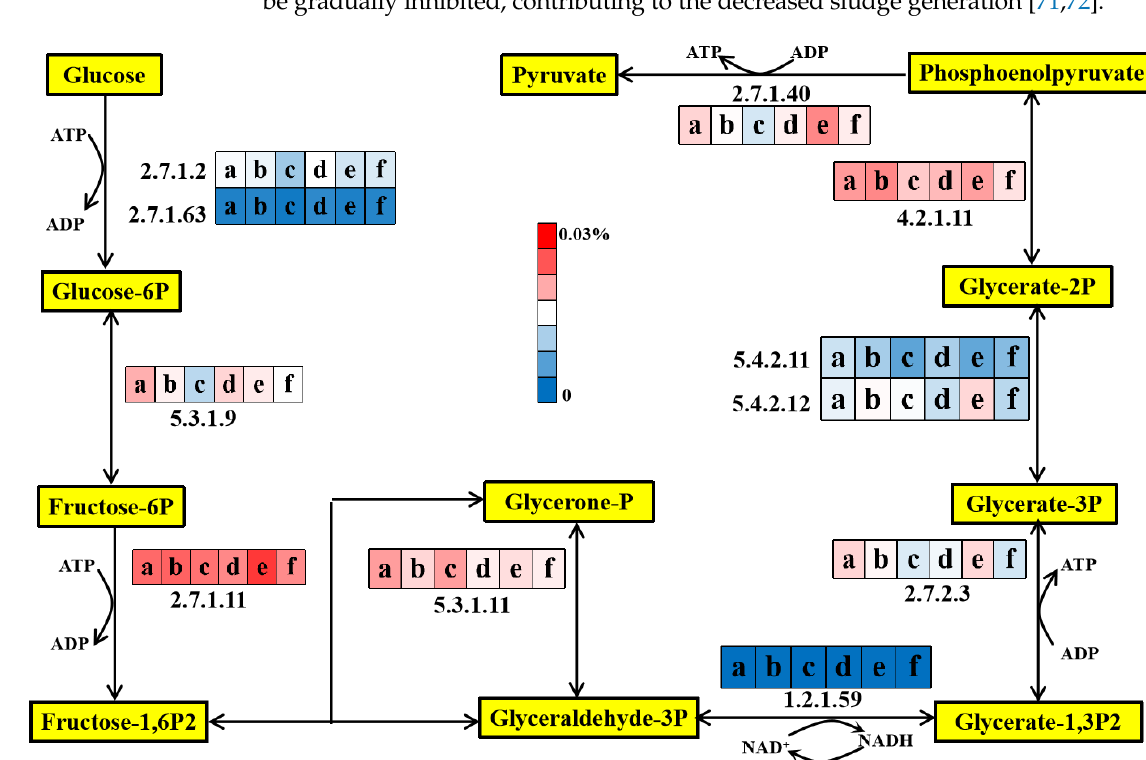
Figure 5. Glycolysis pathway and average relative abundances of enzyme-encoding genes in AOA S150 and AOA S300 bioreactors (a, c, and e represent the initial, middle, and final stage of AOA S150 ; b, d, and f represent the initial, middle, and final stage of AOA S300 ,